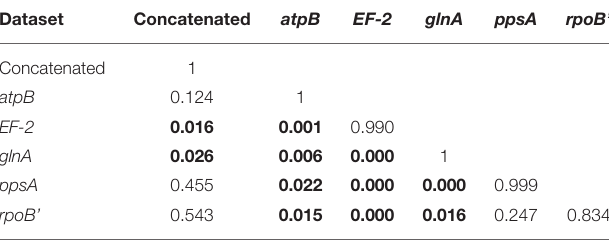
TABLE 2 | Phylogenetic topology congruence analysis.